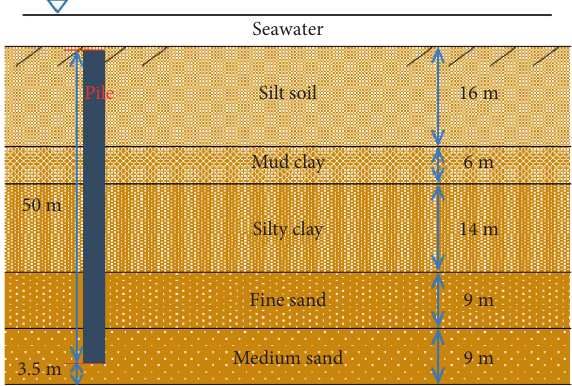
Figure 2: Schematic diagram of the soil Table 1: Main parameters of soil layers.